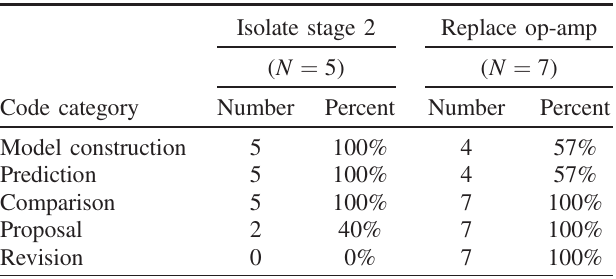
TABLE IV. Number and percent of groups who engaged in a particular aspect of the Modeling Framework in each of two troubleshooting episodes: isolating stage 2 as the source of faults, and replacing the faulty op-amp. Percents were computed relative to the total number of groups who engaged in the corresponding troubleshooting